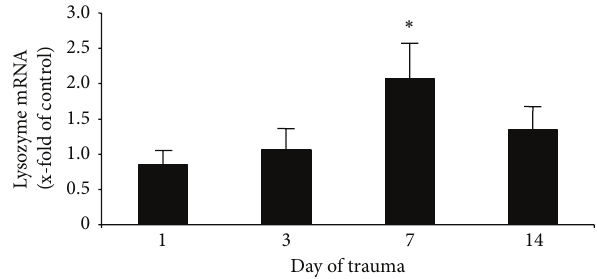
Figure 2: Induction of lysozyme expression in leucocytes of multiply injured patients . Gene expression analysis using real-time PCR in leukocytes of multiply injured patient indicates on day 7 significant higher lysozyme levels as compared to healthy controls; ∗ 𝑃 < 0.01